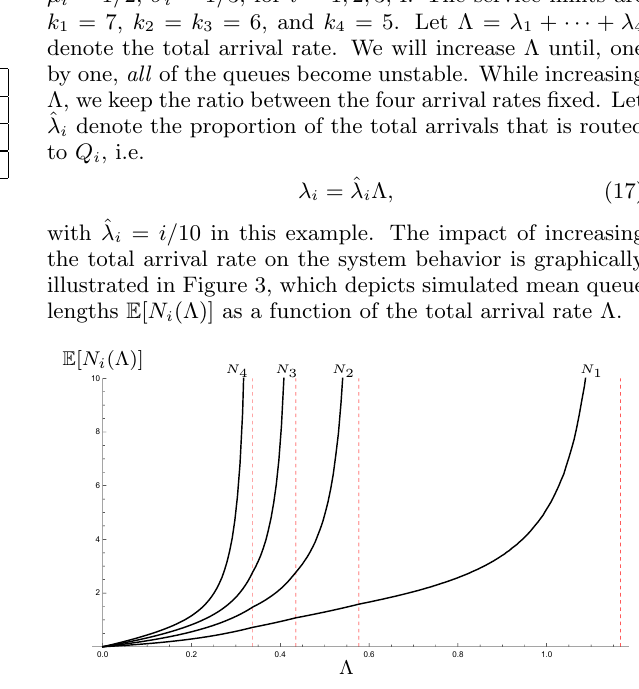
Figure 3: The mean queue lengths in Example 4 as functions of the total arrival rate Λ . The four vertical dashed lines correspond to respectively Λ crit 4 , Λ crit 3 , Λ crit 2 , Λ crit 1 (from left to